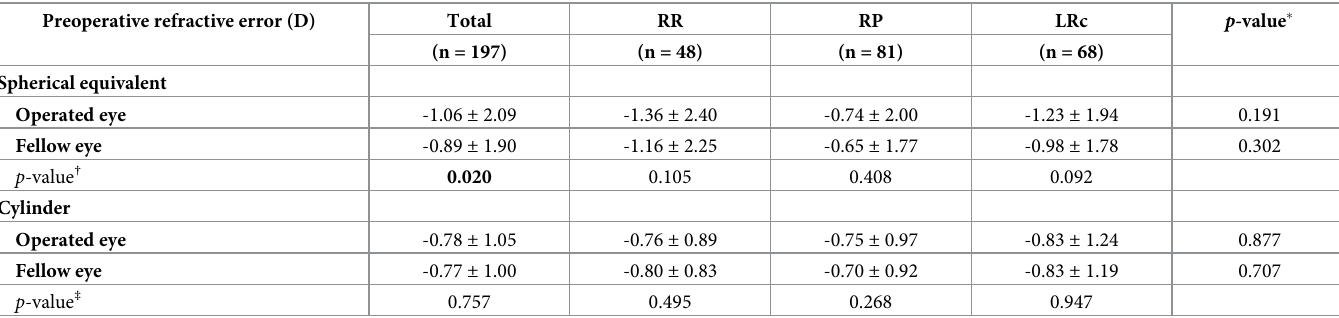
Table 3. Preoperative refractive errors in both